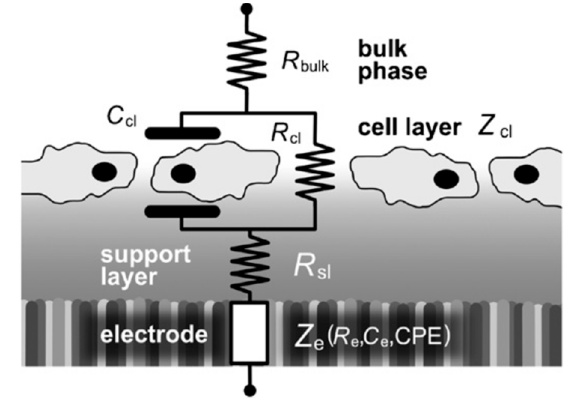
Figure 5. Experimental design of mammalian cells on fibronectin layer along with corresponding equivalent circuit characteristic for impedance spectroscopy.